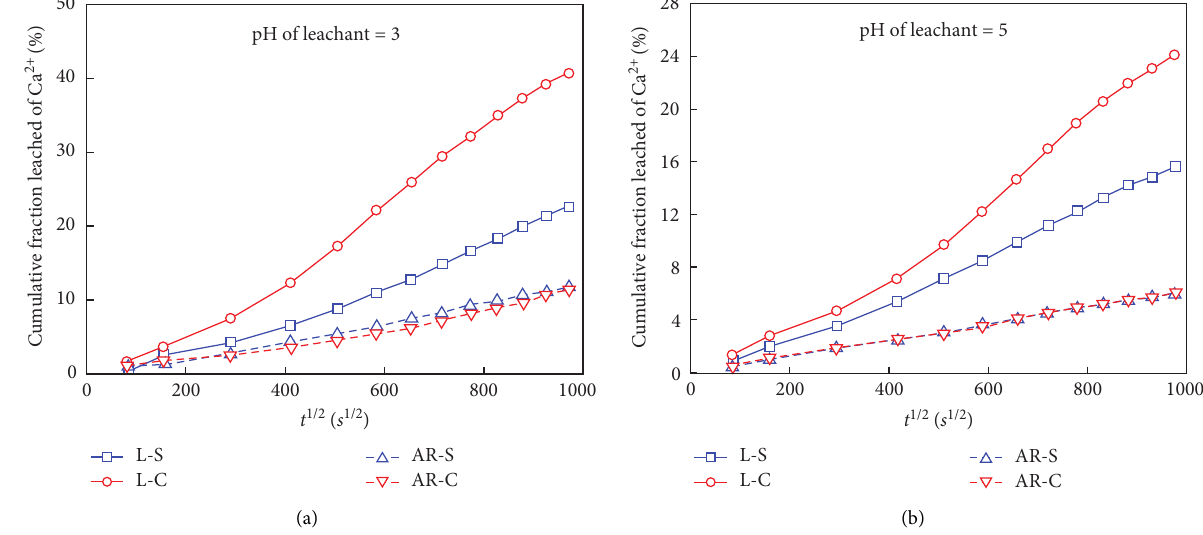
Figure 8: The evolution of cumulative fraction leached (CFL) of Ca 2+ with time ( s 1/2 ): (a) leachant pH of 3 and (b) leachant pH of 5.